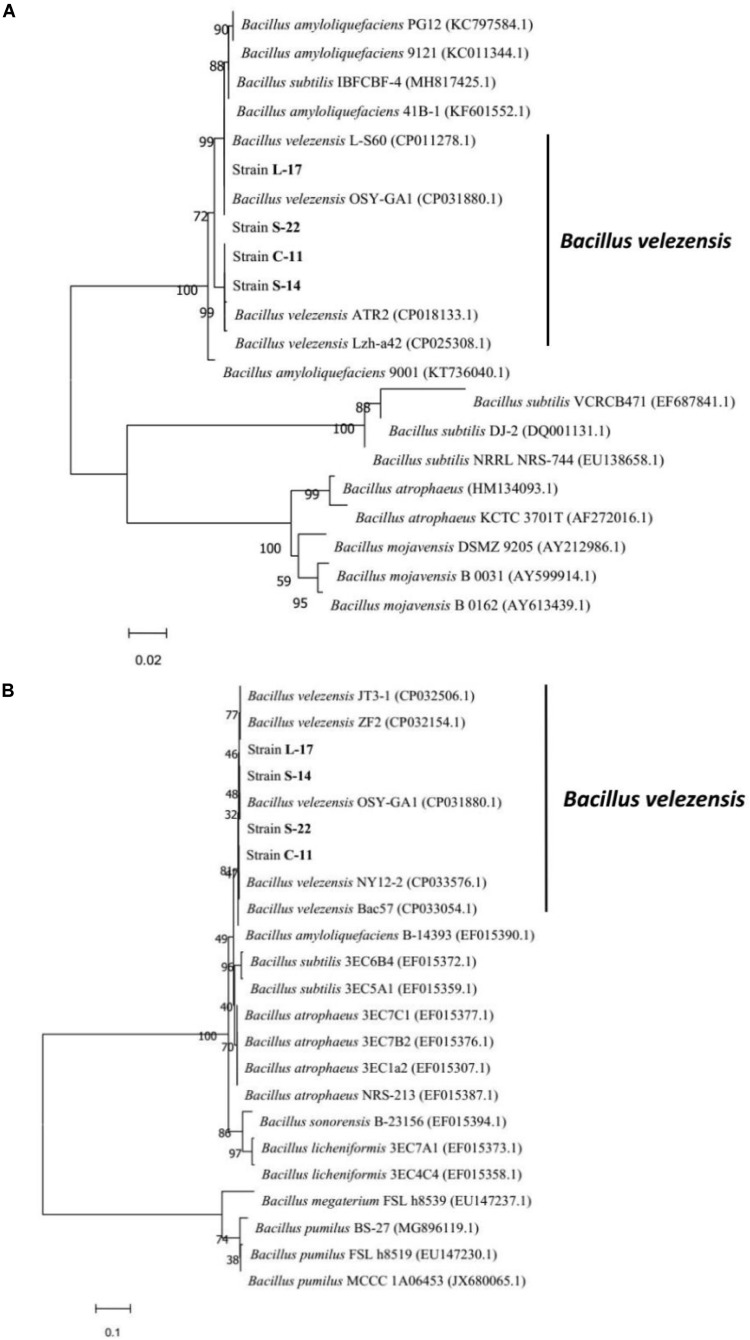
Phylogenetic tree of the closely related species in Bacillus genus based on gyrB (A) and rpoB (B) sequences. The sequences were aligned using Clustal W tool in MEGA 7.0, and phylogenetic analysis was performed using the neighbor-joining method. The bootstrap percentages, based on 10,000 replications, are shown. The scale bars indicate 0.02 or 0.1 substitutions per nucleotide position. The gene accession numbers are shown in the parentheses after each species.